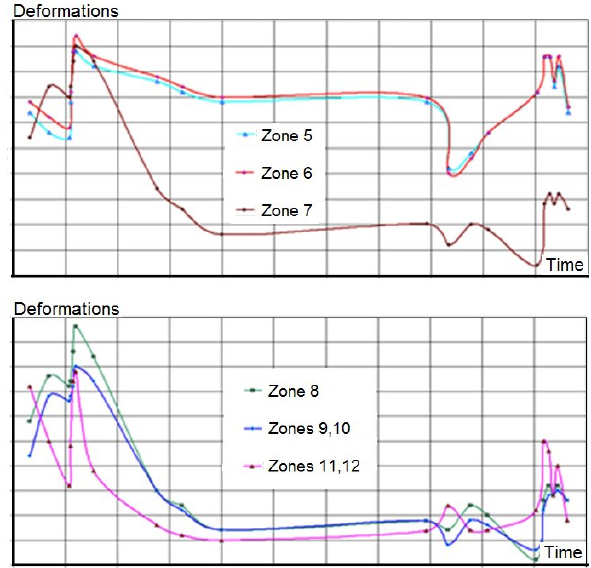
Figure 6: The dependence of the intensity of total deformations in the critical zones of one of the EF on the flight cycle